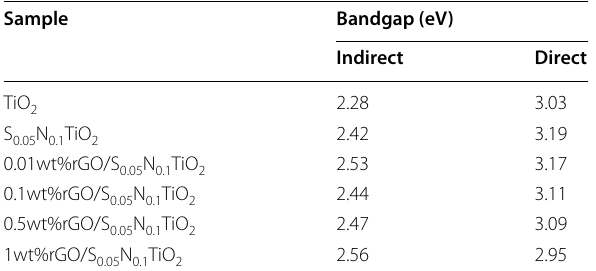
TiO 2 samples [15]. The active photocatalytic activity of rGO/S 0.05 N 0.1 TiO 2 composites might occur under vis- ible irradiation with the incident wavelengths in the range 200–800 nm [30]. Estimation of the band gap ener- gies was calculated by reflectance spectra conversion to absorption Kubelka-Munk units as shown in Table 2 and reveal the reduction of energy gap under the higher rGO content. This phenomenon occurred due to the Ti-O-C bonds of rGO/TiO 2 nanocomposites between TiO 2 nano- particles and rGO nanosheets [15]. 3.2 Visible light‑driven photocatalytic degradation of toluene Toluene in the initial concentration of 2 ppm was used as the pollutant to be degraded by various syn- thesized photocatalyst under the RH of 60% at the temperature of 25 °C. Figure 6 and Table 3 present the toluene conversion and reaction rate during pho- tocatalytic degradation. The results indicate that